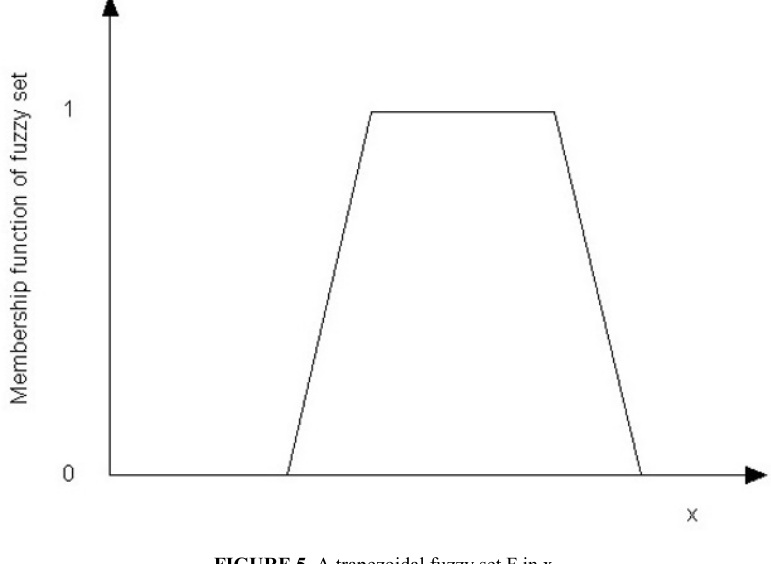
FIGURE 5. A trapezoidal fuzzy set F in